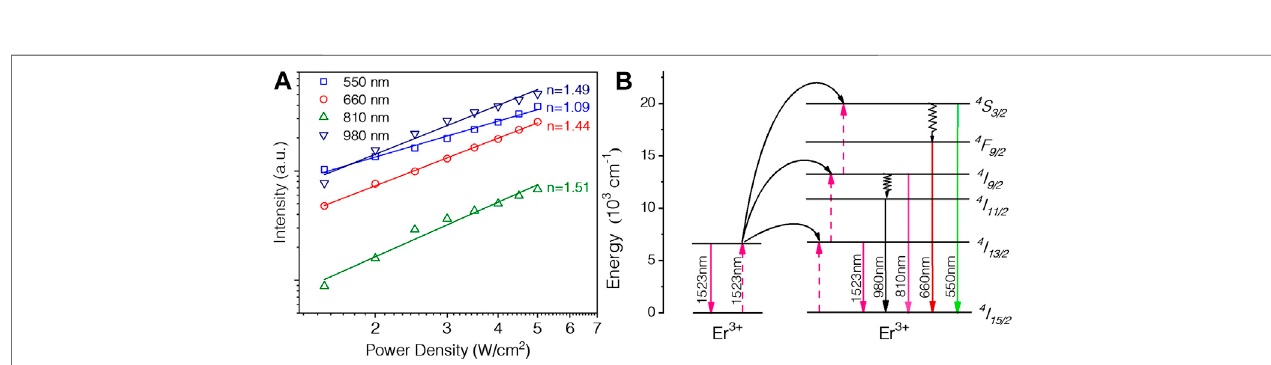
FIGURE 3 | UC emission spectra of (A) LiYF NaGdF 4 :10%Er 3+ @NaGdF 4 nanoparticles, and (D) the integration of their emission peaks excited at 1532 nm.